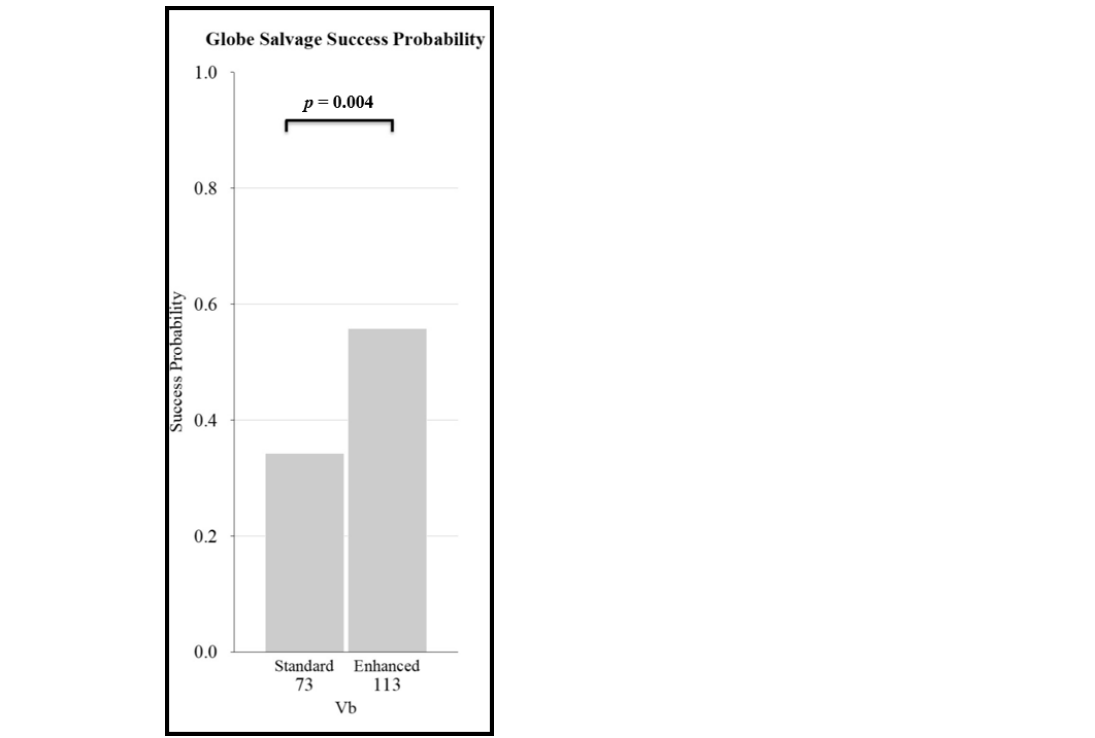
Figure 4. Comparison of globe salvage probability for “standard” vs. “enhanced” intravenous chemotherapy regimens for the most advanced eyes with vitreous seeds (Reese–Ellsworth group Vb).